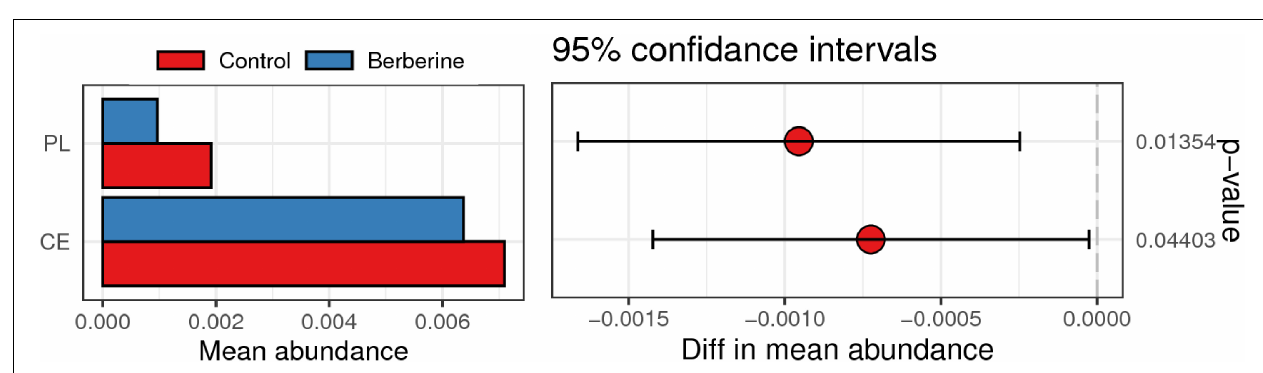
FIGURE 6 | Analysis of CAZy between control and berberine